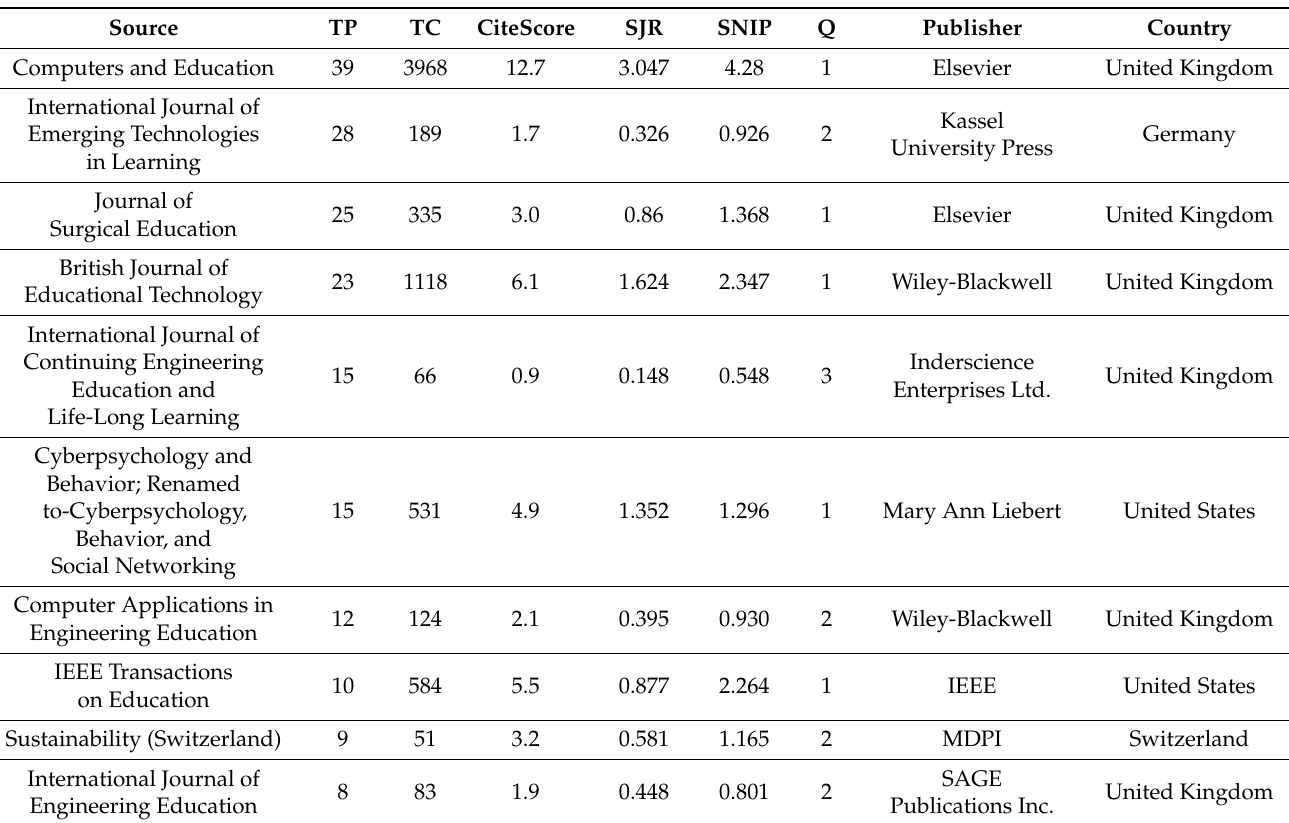
Table 3. Most influential journals on